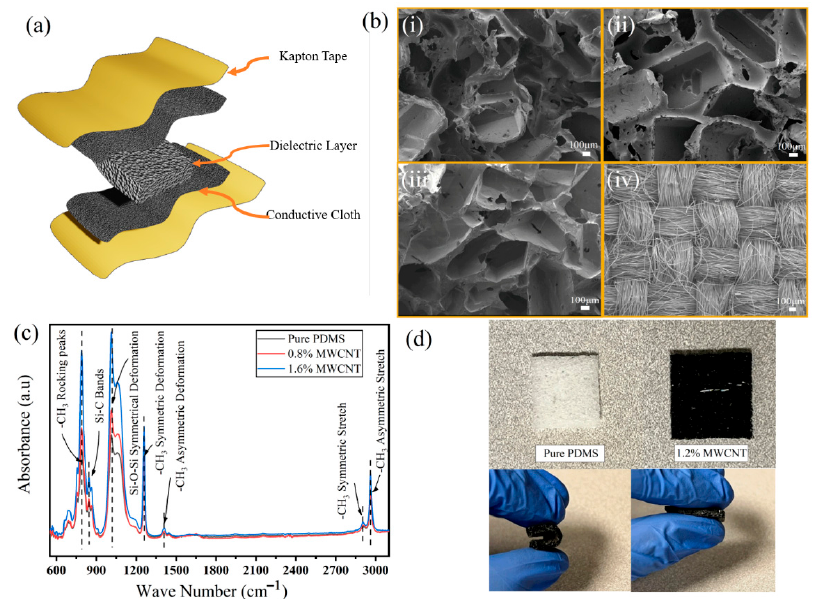
Figure 2. ( a ) Schematic illustration of the sensor. ( b ) SEM images of the porous MWCNT − PDMS ( i – iv ) SEM images of pure porous PDMS, 1.2 − MWCNT − PDMS, 2 − MWCNT − PDMS, and conductive textile electrode, respectively. ( c )